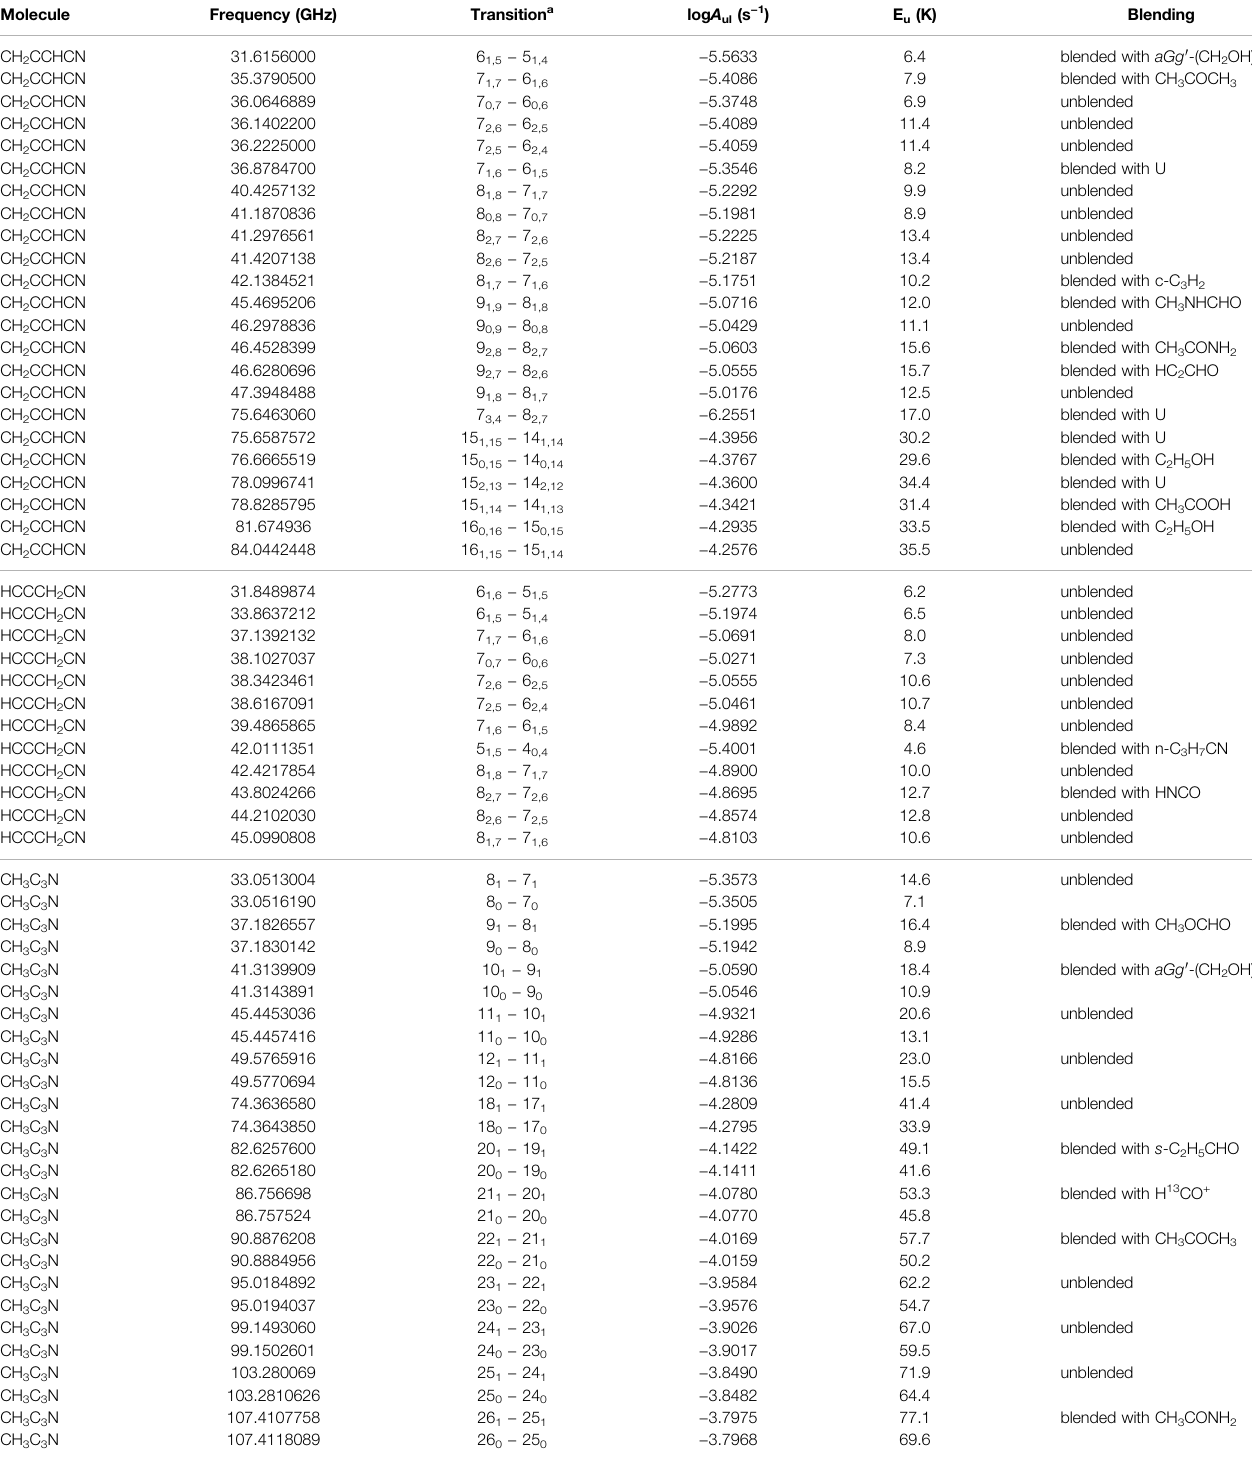
TABLE 3 | List of observed transitions of the C 4 H 3 N isomers analysed in this work. We indicate the frequency, quantum numbers, Einstein coef fi cient ( A ul ), energy of the upper levels of each transition (E u ), and information about the possible blending by other identi fi ed or unidenti fi ed (U) species towards G +0.693.